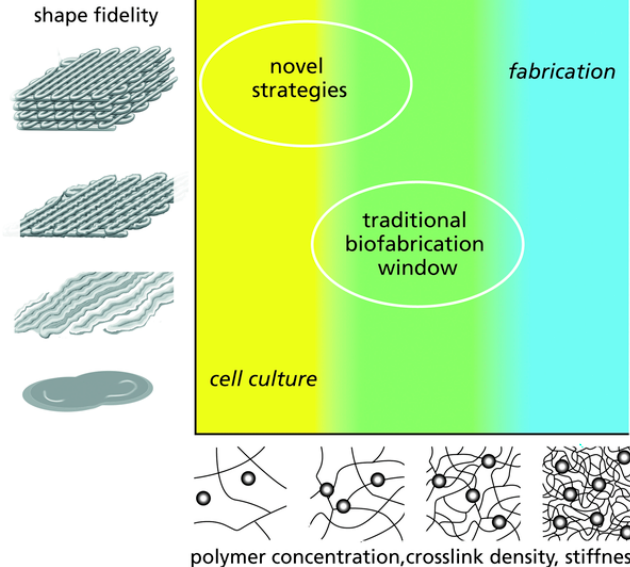
Figure 8. Schematic of the challenges for engineering bioinks suitable for 3D printing. Optimal shape fidelity can be typically achieved with stiff hydrogels ( top right ), however, this dense network limits cell viability. Contrarily, cell survive best in soft hydrogels, but shape fidelity cannot be achieved ( bottom left ). Therefore, a compromise between biological and fabrication properties must be done ( middle ). Novel strategies aimed at obtaining high shape fidelity with cytocompatible hydrogels. Reproduced from [105] with permission. Copyright (2009) Wiley-VCH.